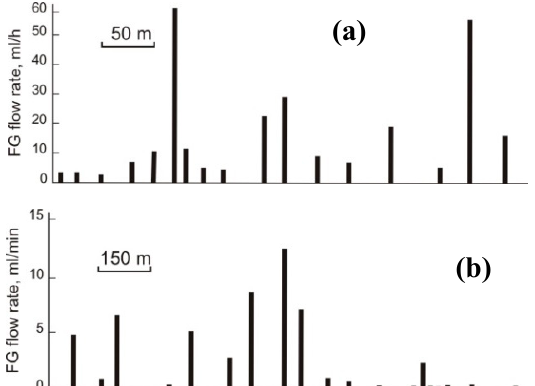
Figure 6. Position of horizontal shot-holes with various free gas (FG) flow rates in the walls of Drift 8/25 (up) and Roadway 23-Eastern (down), Karnasurt Mine, Lovozero loparite deposit (from [18], with modifications).